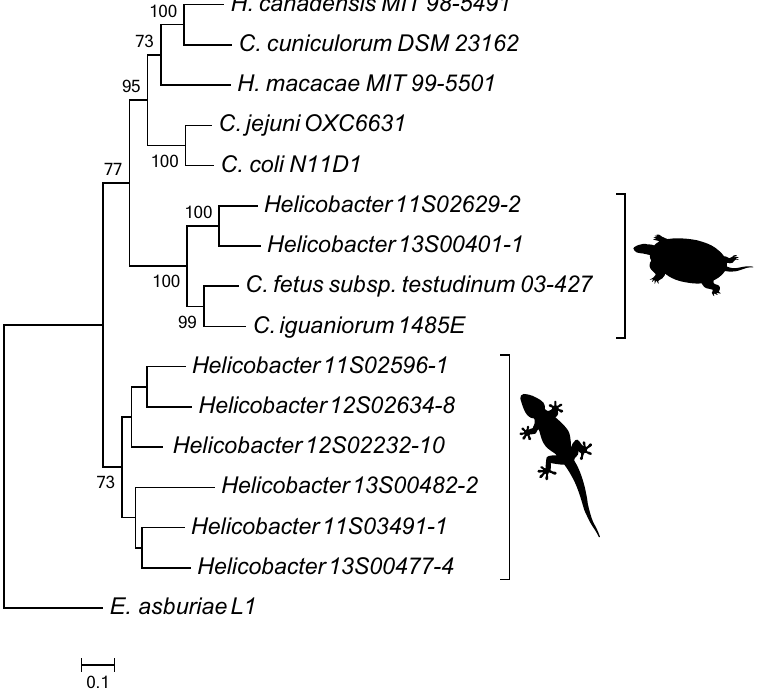
Figure 2. Rooted single gene maximum likelihood dendrogram based on tcuC from Helicobacter and Campylobacter . The chelonian- and squamate-associated strains are indicated with a chelonian or lizard, respectively. Enterobacter asburiae L1 was used as outgroup and root. Bootstrap values ( ≥ 70%) based on 500 repetitions are shown at the nodes of the